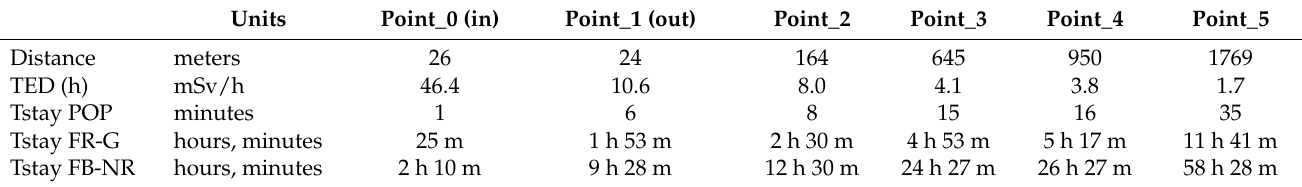
Table 4. Calculation of the equivalent dose and of the average residence time at various distances from the point of explosion of a source of Co-60 with an activity of 1.5 × 10 5